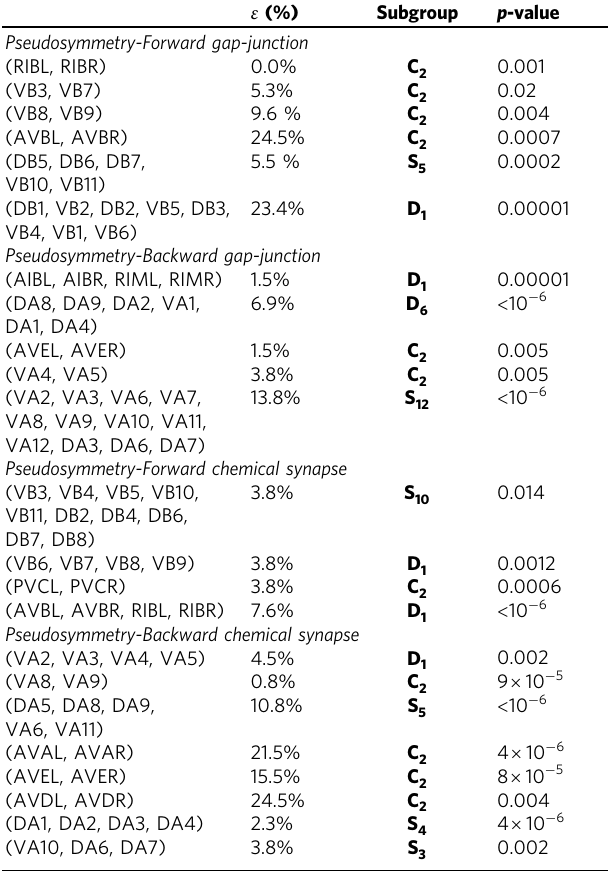
Table 1 Pseudosymmetries of the locomotion